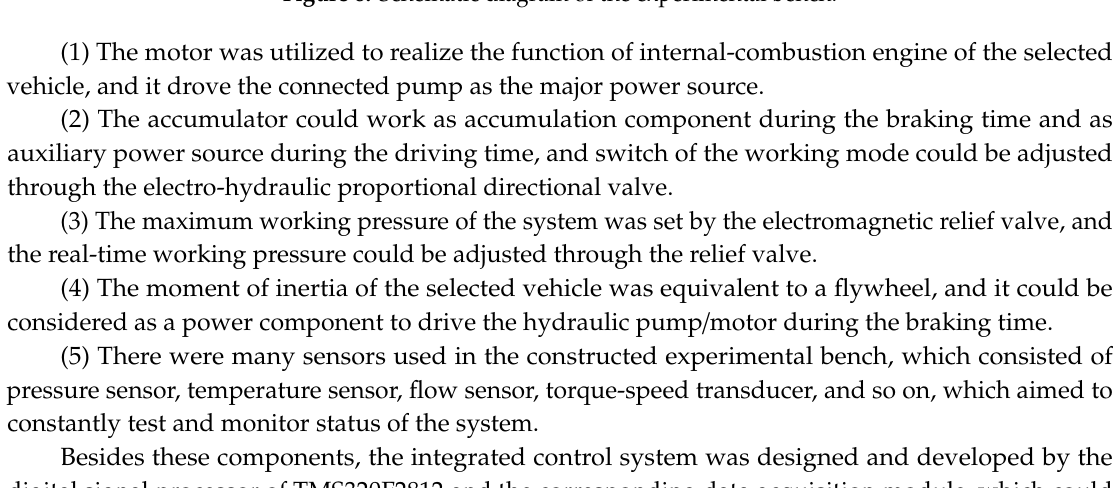
Figure 8. Schematic diagram of the experimental bench.